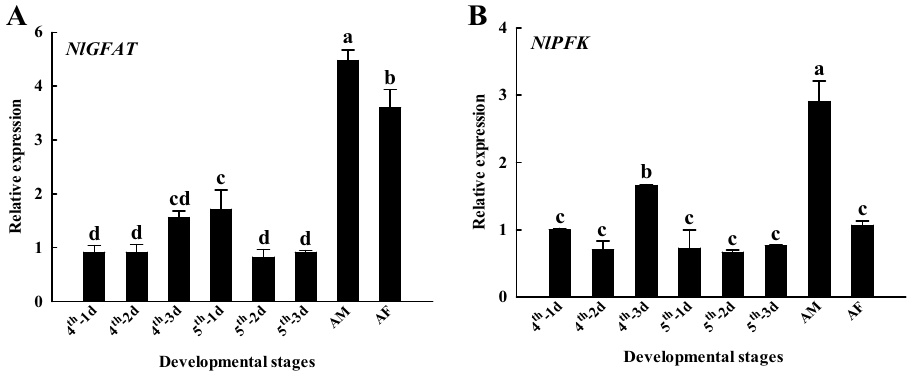
Figure 1. Expression levels of GFAT ( A ) and PFK ( B ) genes in different developmental stages of Nilaparvata lugens . GFAT, glutamine:fructose-6-phosphate aminotransferase; PFK, phosphofructokinase. Expression levels were measured by quantitative real-time PCR, with 18S RNA as the internal control. Values are means ± SE from three independent measurements. The age of N. lugens was defined as follows: 4th—1d, 1st day of fourth instar nymph; 4th—2d, 2nd day of fourth instar nymph; 4th—3d, 3rd day of fourth instar nymph; 5th—1d, 1st day of fifth instar nymph; 5th—2d, 2nd day of fifth instar nymph; 5th—3d, 3rd day of fifth instar nymph; AM, male adult; AF, female adult. Different letters indicate significant differences according to Duncan’s test ( p < 0.05).